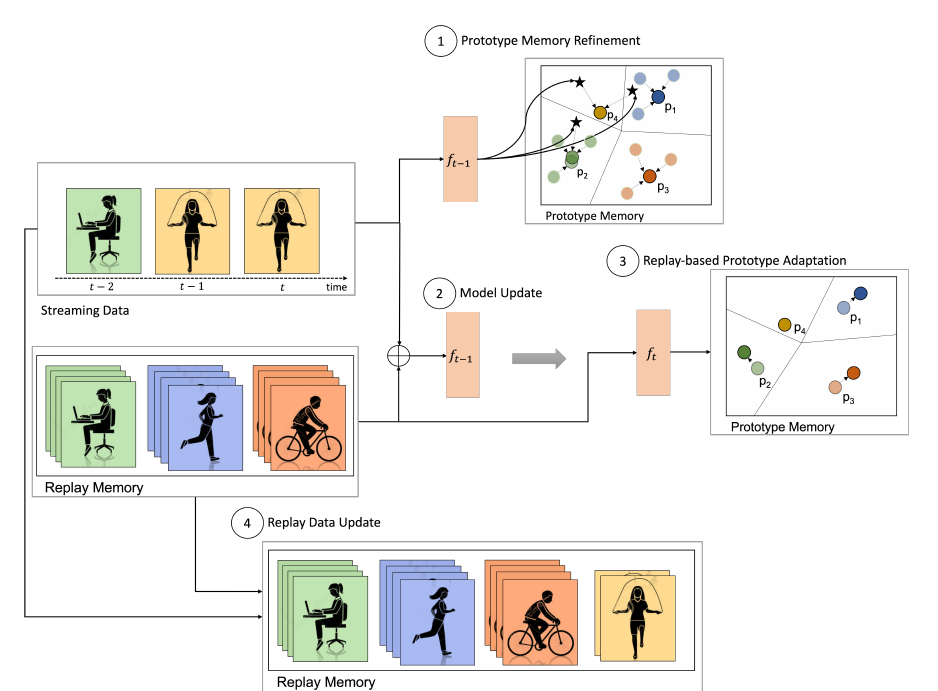
Figure 1. LAPNet-HAR Overview. Given a pretrained model at time t − 1 with a prototype memory containing prototypes of old classes as well as a replay buffer with a subset of old data samples, the new batch of streaming data is first used to update the prototype memory by using online averaging on old classes and creating prototypes of new classes (step 1). Then, with the updated prototypes, the data is combined with the replay data to update the model parameters (step 2). To prevent prototype obsolescence and adapt to the new latent space, the prototypes are adapted using the new embeddings of the replay data (step 3). Lastly, the replay memory is updated by random sampling from the current batch and extended to include new classes (step